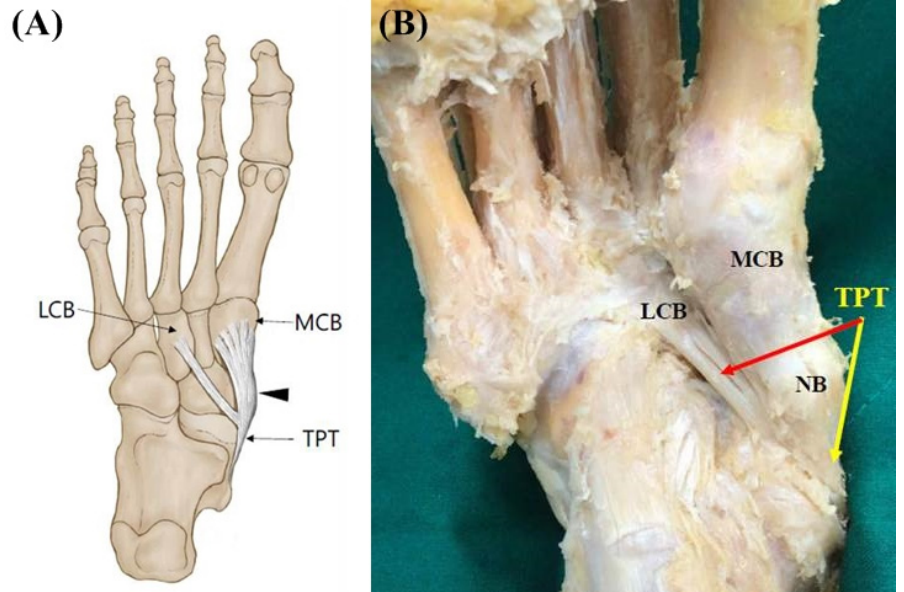
Figure 2. ( A ) Schematic drawing of the Type 2 tibialis posterior tendon insertion. Black-colored arrow indicates TPT inserts to the navicular bone. ( B ) Photo of the Type 2 tibialis posterior tendon insertion. The main tendon inserts to the navicular bone and the medial cuneiform bone (yellow-colored arrow). The second accessory tendon inserts to the lateral cuneiform bone (red-colored arrow). TPT, tibialis posterior tendon; NB, navicular bone; LCB, lateral cuneiform bone; MCB, medial cuneiform